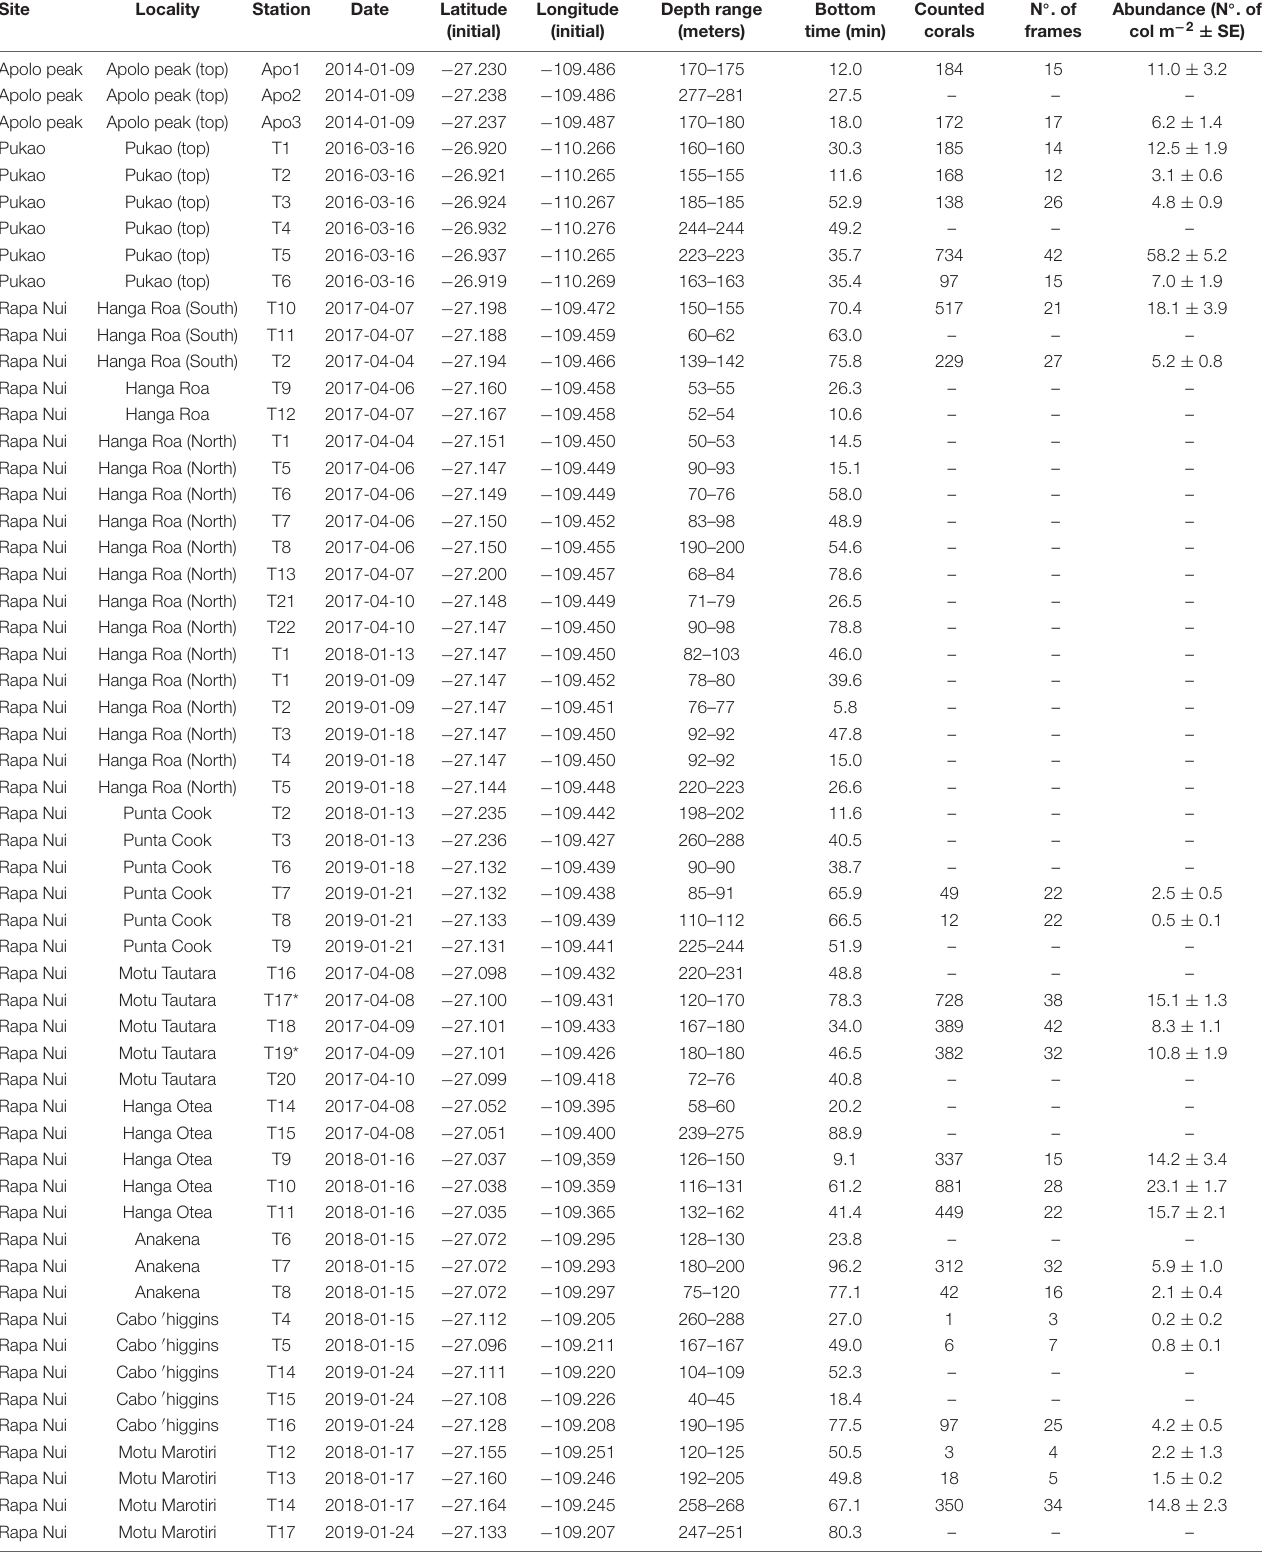
TABLE 1 | Summary information of ROV video transects conducted as part of this study. Site